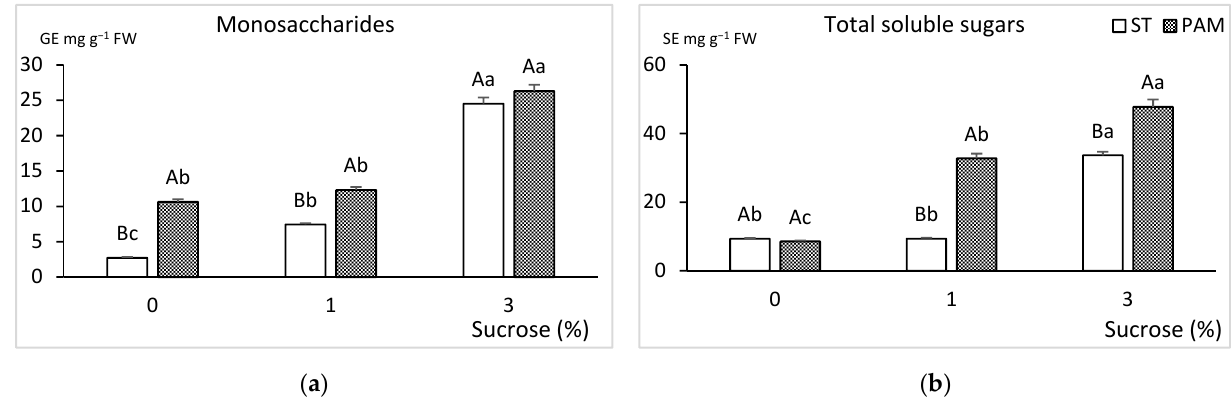
Figure 8. Effect of growth conditions and sucrose supplementation on the carbohydrate concentration of leaves of genotype CBP cultured in RITA© with 6 immersions/day. ( a ) Monosaccharides and ( b ) total soluble sugars. Different uppercase letters indicate significant differences in relation to the growth conditions, and different lowercase letters indicate significant differences in relation to the sucrose supplementation ( p < 0.05). ST: standard conditions, PAM: photoautotrophic conditions and FW: fresh weight. SE: sucrose equivalents and GE: glucose